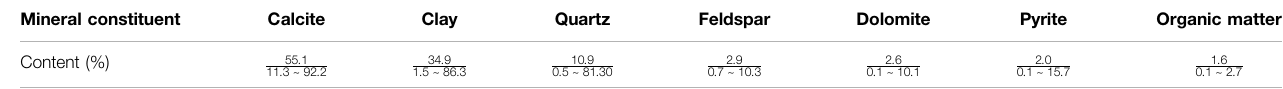
TABLE 5 | Mineral constituents of X-ray diffraction whole-rock analysis. Mineral